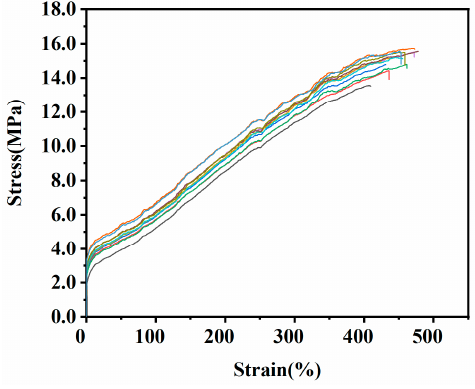
Figure 8. Stress–strain curves of the EPDM rubber composite under simple tension. Table 1. Mechanical properties of di ff erent